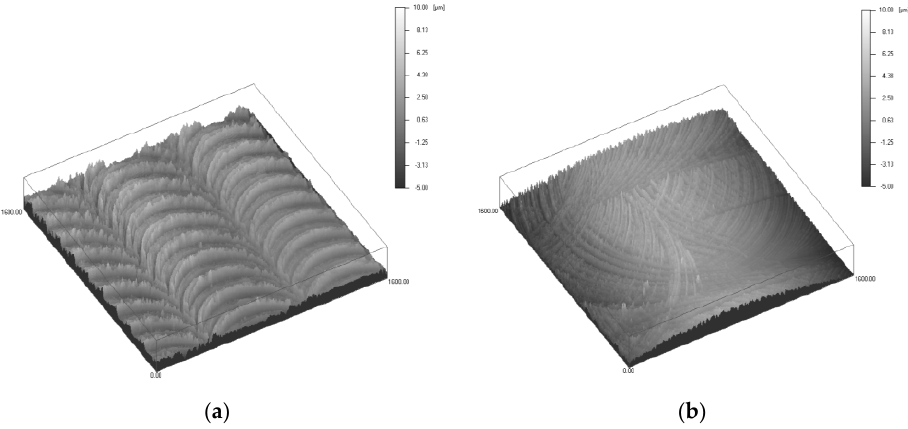
Figure 10. 3D profile for surface roughness of two types of housing channel ( a ) type 1; ( b ) type 2. Table 1. Surface roughness of different types of channels.